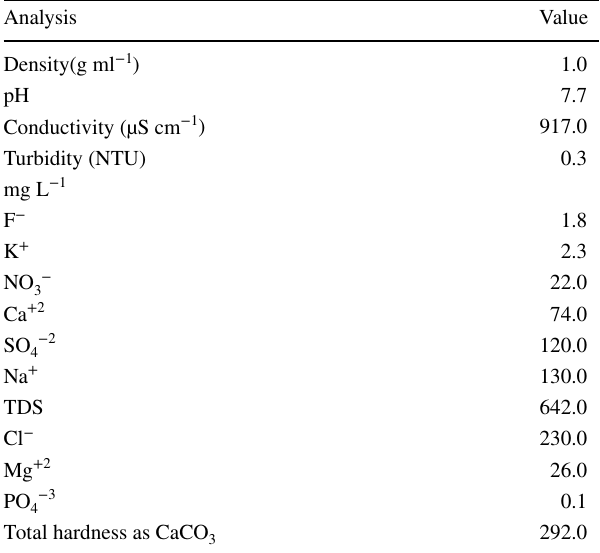
Table 2 Chemical analysis for Wadi Al-Yutum groundwater used in